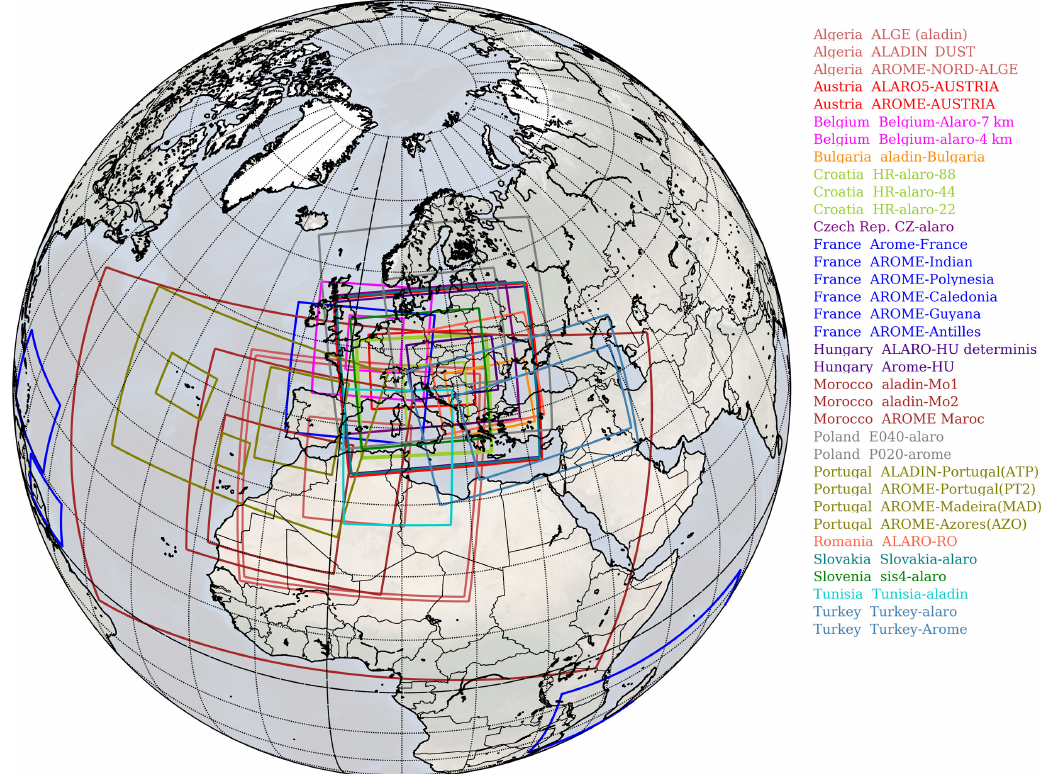
Figure 6. The operational domains of ALADIN System within the ALADIN consortium (situation in April 2017).